Question: Based on the figure, does the quantity rise or fall?
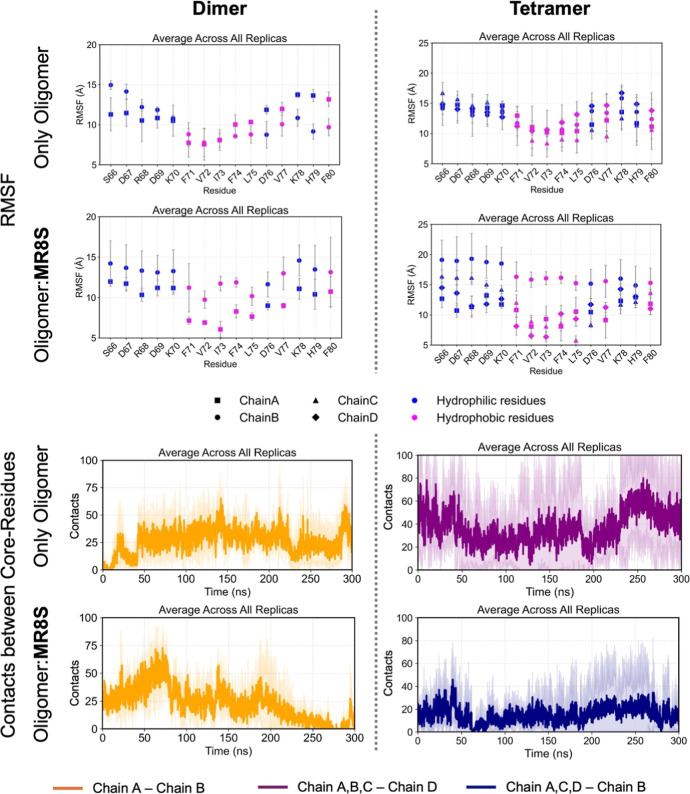
Answer: increasing